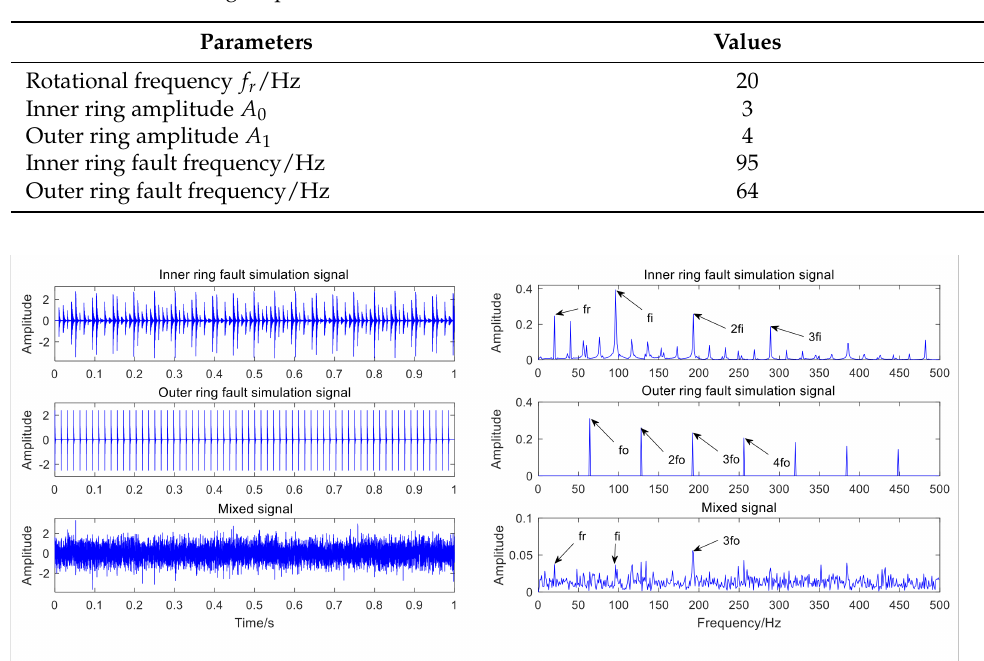
Table 1. Simulation signal parameters.